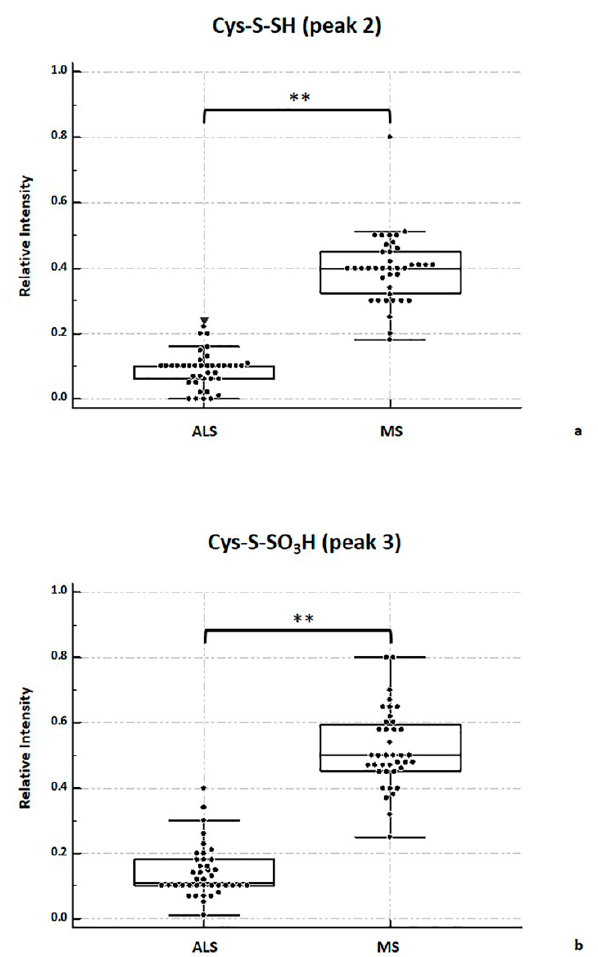
Figure 6. Relative intensity of TTR mixed disulfide isoforms comparing CSF MALDI spectra of ALS and MS groups. Panel ( a ) shows sulfhydrated-TTR isoform (Cys-S-SH, peak 2). Panel ( b ) shows sulfonated TTR isoform Cys-S-SO3H peak 3). Data were analyzed with the Mann–Whitney test; ** indicates a p < 0.001.